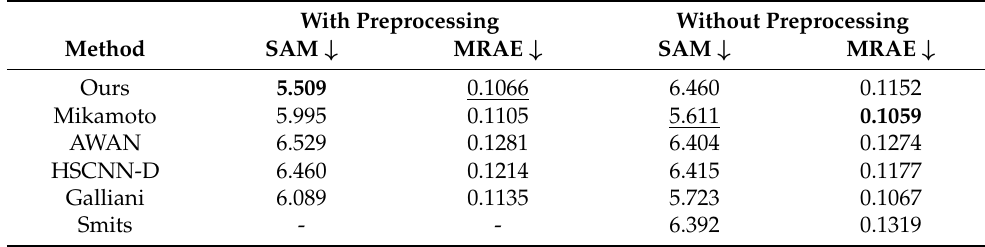
Table 3. Results on the ME HS dataset. Bolded and underlined indicate the best and second-best results, respectively.